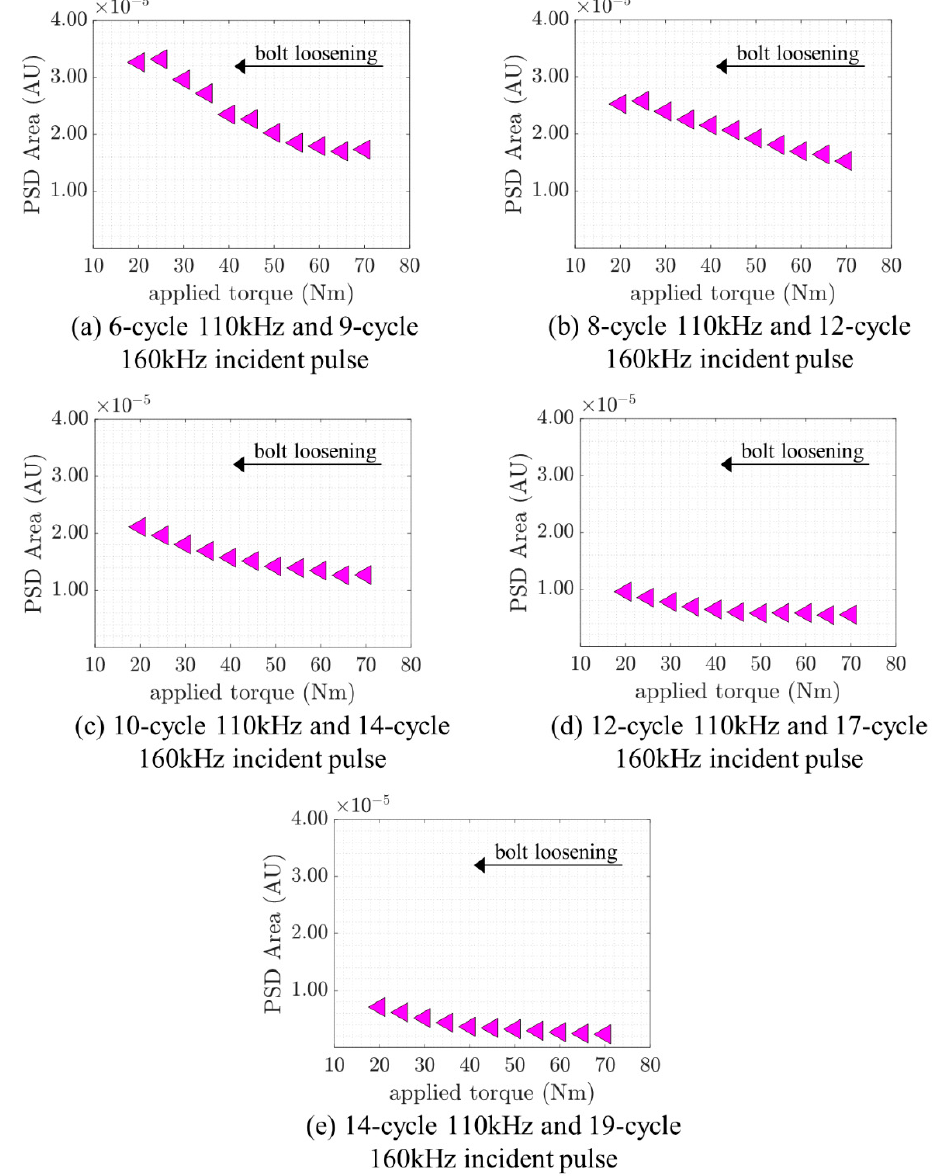
Figure 10. Relationship between PSD area and applied torque.